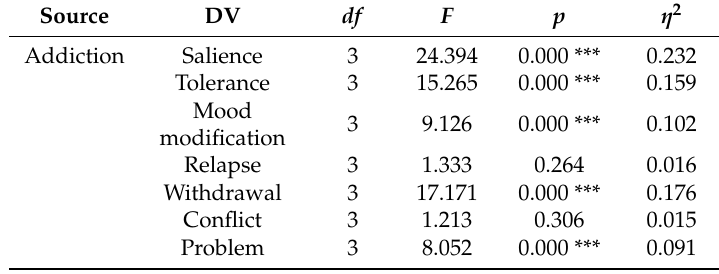
Table 3. Results of MANOVA: Differences in addiction in esports between four groups based on the forms of families.